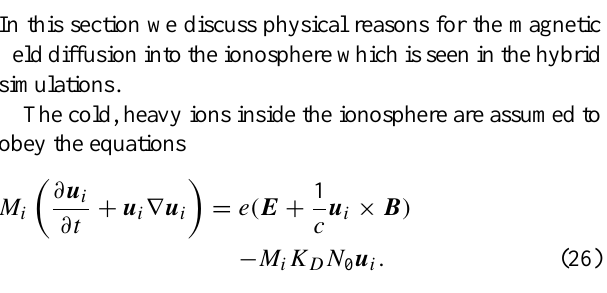
For the input solar wind parameters (11) we find M A =10, δ p =114 km. Taking the scale 1 m ∼ 0 . 1 R M from the